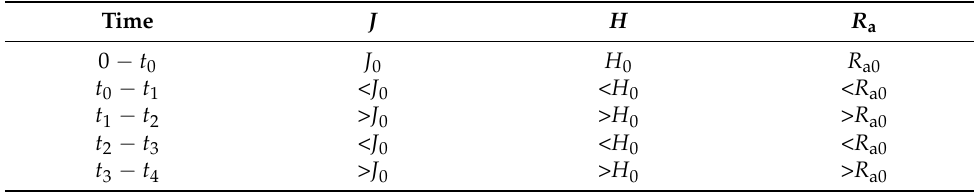
Figure 11. Output voltage curve of the converter when disturbed. Table 1. Values of J , H , and R a .